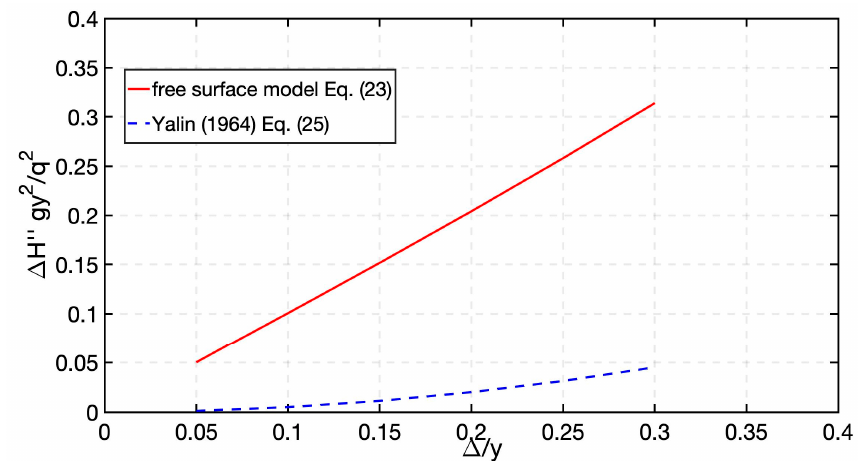
Figure 2. Difference between free surface flow approach, and pressure pipe flow approach. Figure 2. Di ff erence between free surface flow approach, and pressure pipe flow